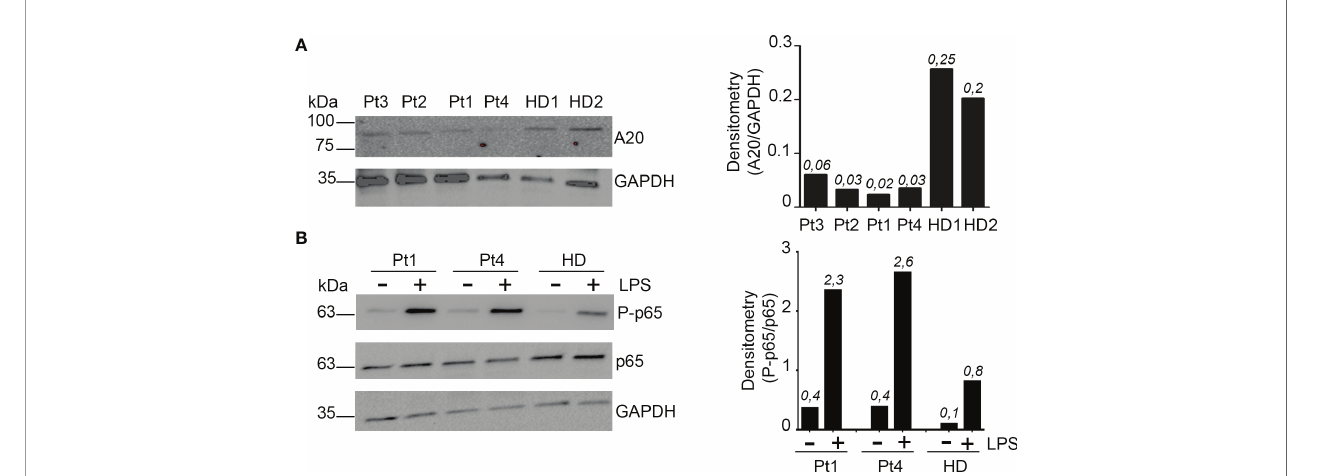
FIGURE 2 | Reduced A20 function in vivo . (A) Western Blot and densitometric analysis of A20 protein levels in PBMCs isolated from patients (Pt1-4) and 2 healthy donors (HD). GAPDH was used as loading control. Densitometric quanti fi cation of A20 was reported (right graph). (B) PBMCs isolated from Pt1, Pt4 and one healthy subject (HD) were starved for 2 h in media with 0.5% of FBS and lysed or stimulated for 30 minutes with 0.01 m g/ml LPS and then lysed. Phosphorylated (S536) p65 NF-kB (P-p65) and total p65 NF-kB protein levels were assessed by Western blot analyses. GAPDH was used as loading control. The phosphorylated-p65 NF-kB/ total p65 NF-kB densitometry comparative ratio was also reported (right graph). Similar results were obtained in two independent